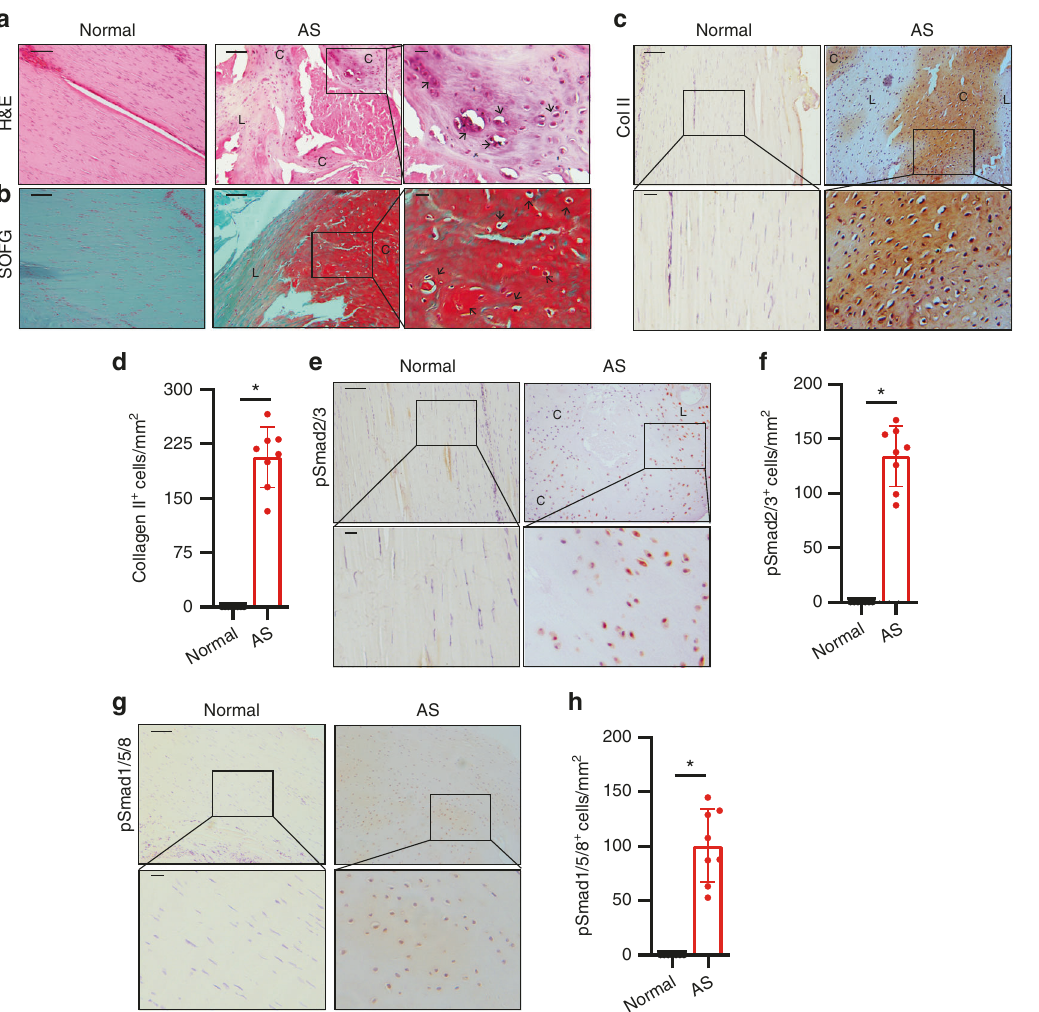
Fig. 3 Chondrocyte differentiation and cartilage formation in interspinous ligaments of AS patients before calci fi cation. a Hematoxylin and eosin (H&E) staining and b Safranin O – Fast Green (SOFG) staining of normal and chondrogenic interspinous ligaments. In the AS group, the right panels show magni fi ed views of the boxed area in the left panels. Scale bar: 100 μ m (two panels on the right side); 25 μ m (left panel). c Immunostaining and d quantitative analysis of collagen II-positive cells (brown) in the normal and chondrogenic interspinous ligaments (sagittal view). The bottom panels show a magni fi ed view of the boxed area in the top panels. Scale bar: 100 μ m (top panel); 25 μ m (bottom panel). e Immunostaining and f quantitative analysis of pSmad2/3-positive cells (brown) in the normal and chondrogenic interspinous ligaments (sagittal view). The bottom panels show magni fi ed views of the boxed area in the top panels. Scale bar: 100 μ m (top panel); 25 μ m (bottom panel). g Immunostaining and h quantitative analysis of pSmad1/5/8-positive cells (brown) in the normal and in fl ammatory interspinous ligaments (sagittal view). The bottom panels show magni fi ed views of the boxed area in the top panels. Scale bar: 100 μ m (top panels); 25 μ m (bottom panels). C, cartilage; L,